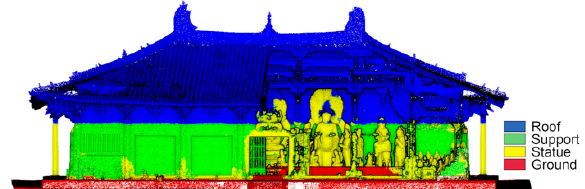
Figure 8. Classification result at level 1 for the east great hall in FKS.